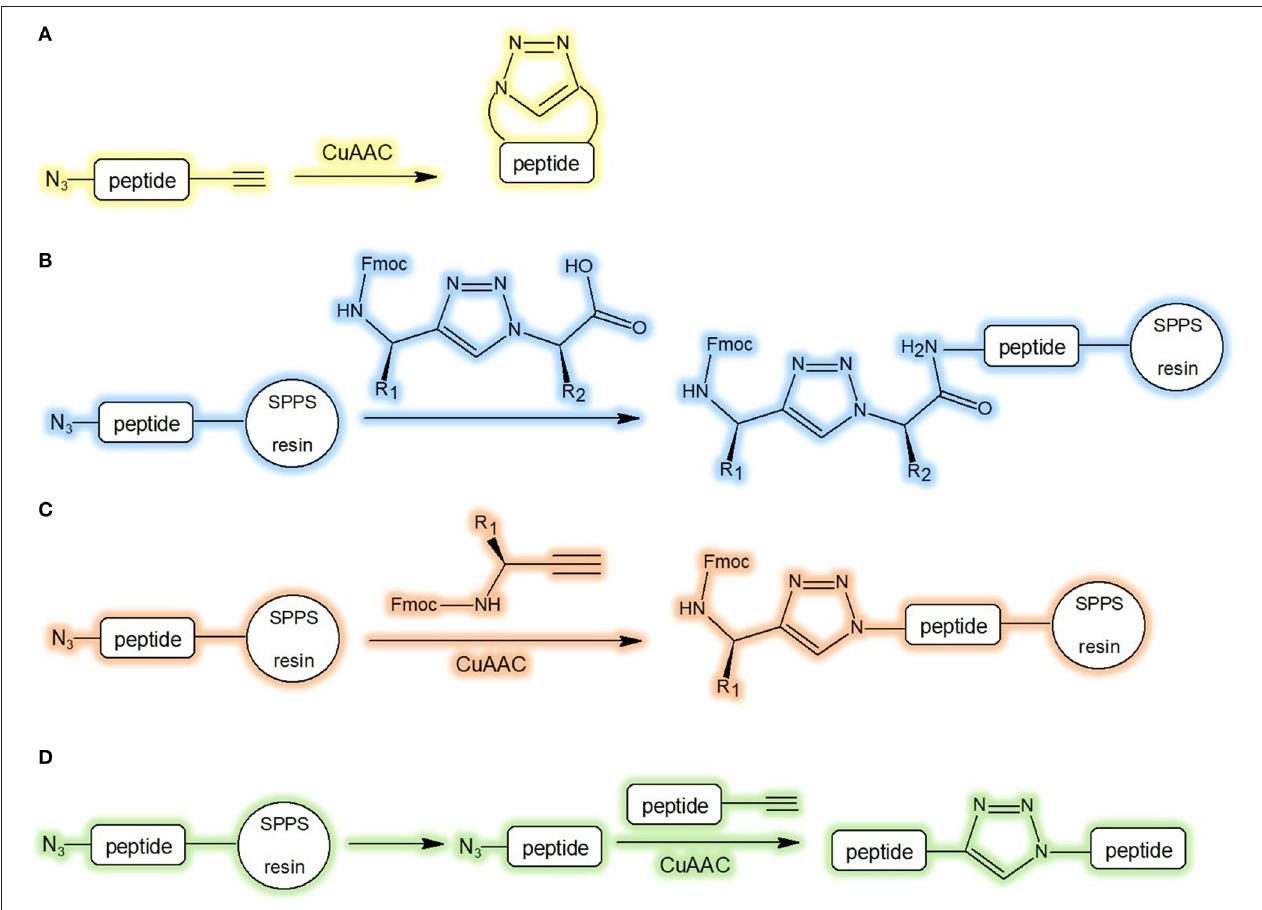
FIGURE 4 | Synthetic strategies of triazolyl containing cyclopeptidomimetics. (A) CuAAC in solution-phase peptide synthesis; (B) incorporation of triazole during SPPS; (C) attachment of triazole to the solid support by CuAAC; (D) conjugation of peptide fragment after CuAAC in solution ( Valverde and Mindt, 2012).